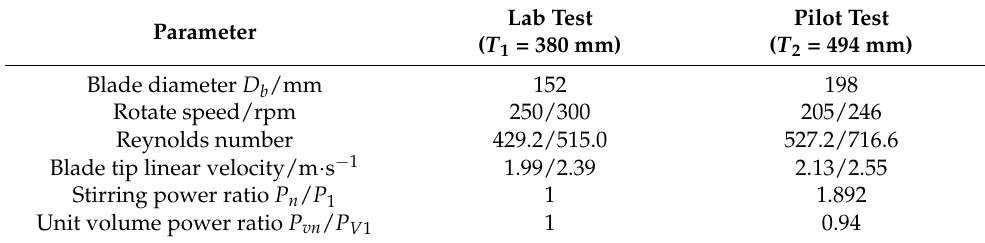
Table 11. Working condition parameters based on the same solid suspension